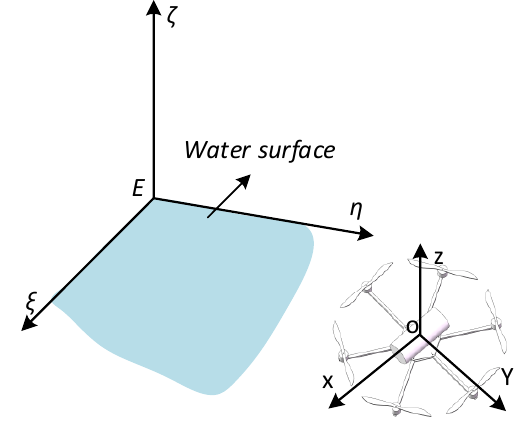
Figure 2. Coordinate system.